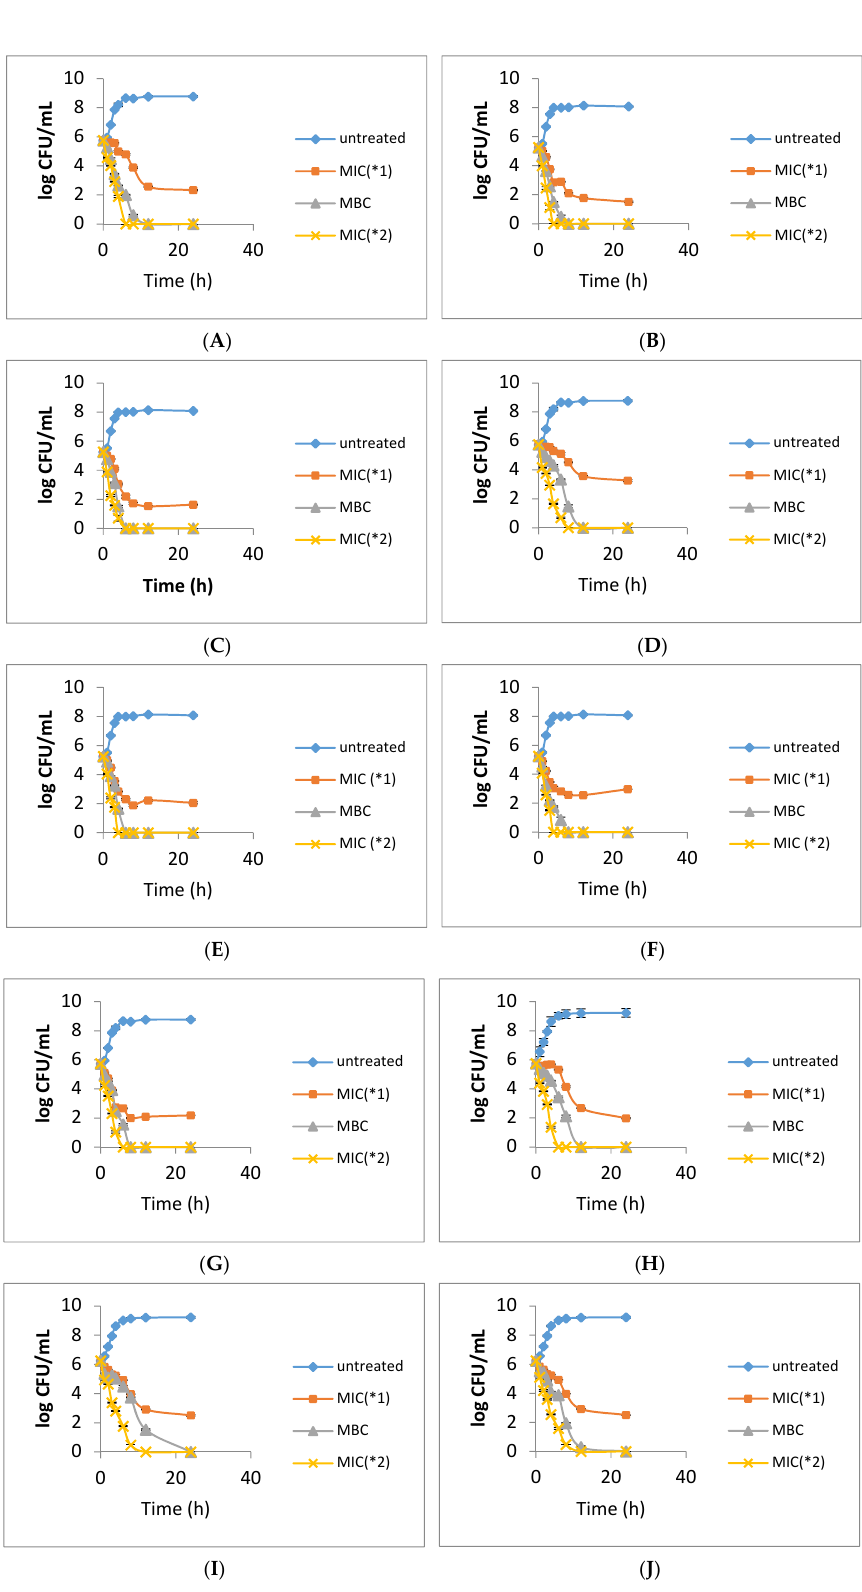
Figure 1. Time–killing curve analysis. ( A ): Ab3394 with leaf SFE extract A; ( B ): Ab3394 with leaf SFE extract B; ( C ): Pa4016 with leaf SFE extract A; ( D ): Pa4016 with leaf SFE extract B ; ( E ): Ab3394 with twig SFE extract A; ( F ): Ab3394 with twig SFE extract B; ( G ): Pa4016 with twig SFE extract; ( H ): Pa4016 with twig SFE extract B; ( I ): Sa2875 with leaf ethanol crude extrac; ( J ): Sa2875 with twig ethanol crude extract.